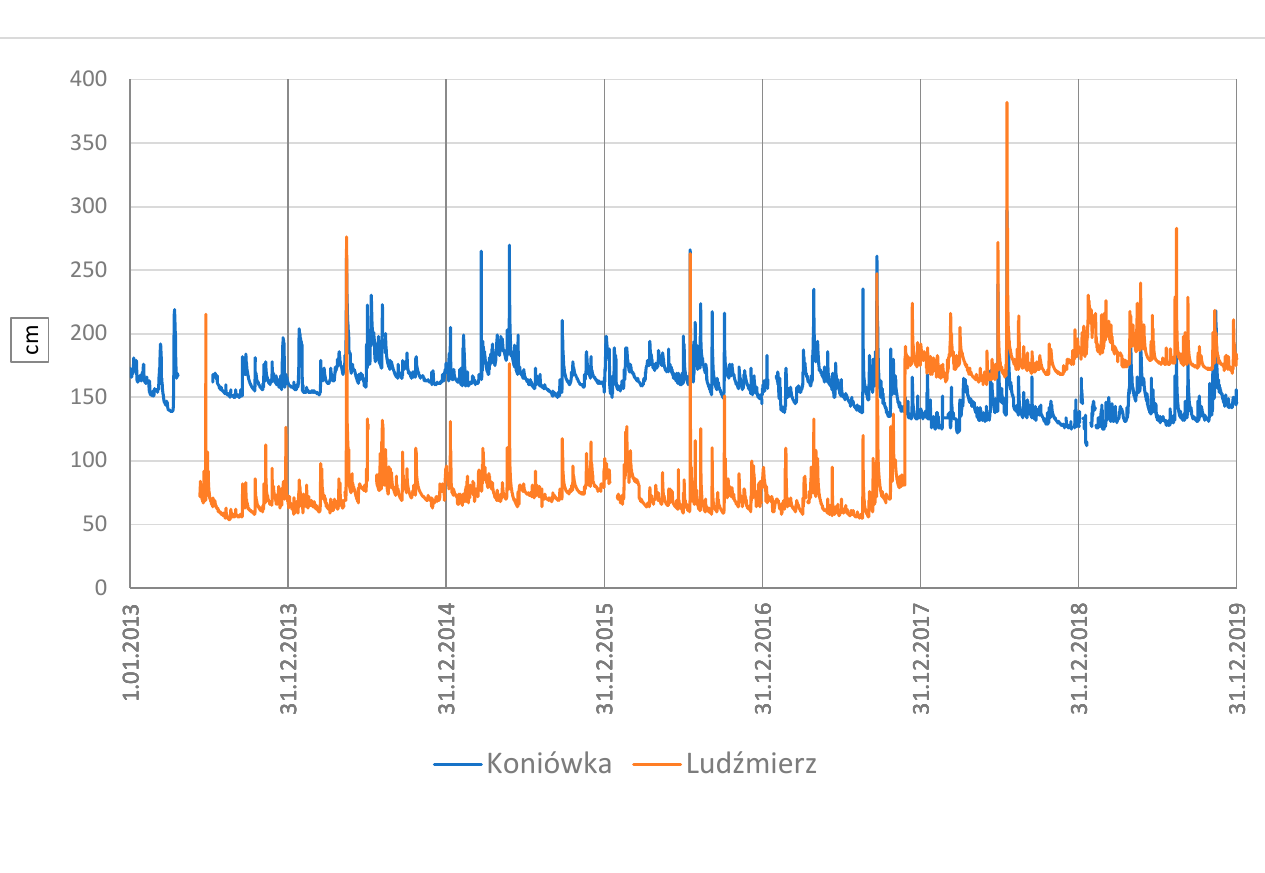
Figure 2. Oscillations of maximum daily water levels in the Czarny Dunajec River (Koniówka gauging station) and the Wielki Rogo ź nik River (Lud ź mierz gauging station; since 2017 the values are higher by 100 cm because of datum relocation).